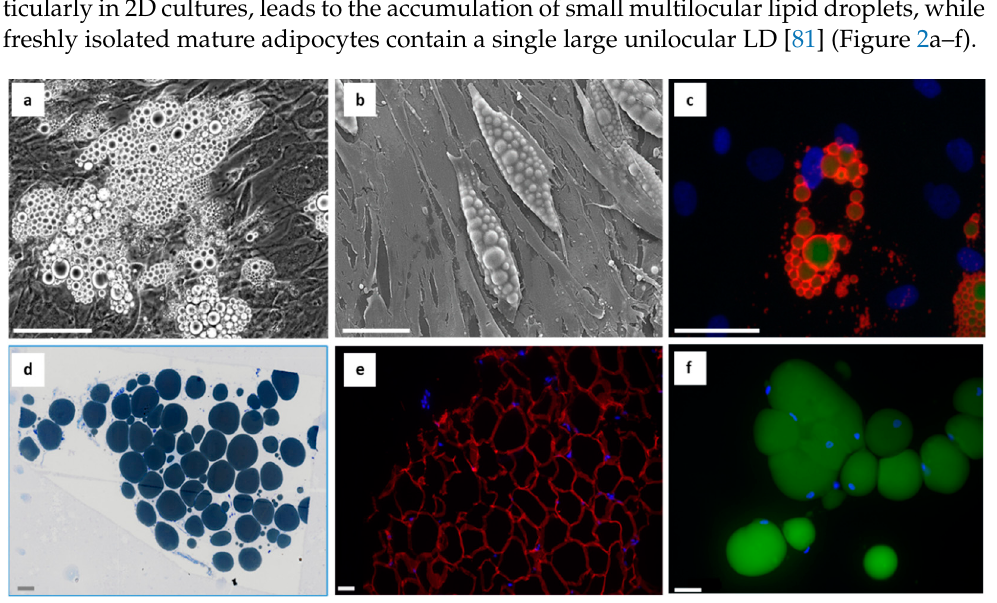
Figure 2. (a–c): In vitro differentiated adipocytes show multilocular lipid droplets after 21 days of adipogenic stimulation from ( a ) light microscopy (live cell imaging) (scale bar: 100 µm); ( b ) scanning electron microscopy (scale bar: 50 µm); ( c ) immunofluorescence staining of perilipin (red), LipidToxTM (green) and DAPI (blue) (scale bar: 50 µm). (d–f): Mature adipocytes in/from subcutaneous adipose tissue show unilocular lipid droplets from ( d ) semithin section from a resin-embedded biopsy-tissue, fixed with Karnovsky’s fixative and post-fixed with OsO4 stained with methylene blue/azurII; ( e ) immunofluorescence staining of a paraffin section from biopsied adipose tissue. Perilipin (red), DAPI (blue) (scale bar: 50 µm); ( f ) immunofluorescence staining of mature adipocytes isolated from liposuction material. LipidToxTM (green), DAPI (blue) (scale bar: 50 µm). So far, information concerning the biogenesis of lipid droplets in lipedema